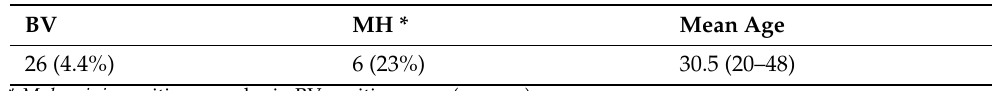
Table 1. The characteristics of positive cases from patients diagnosed with BV.